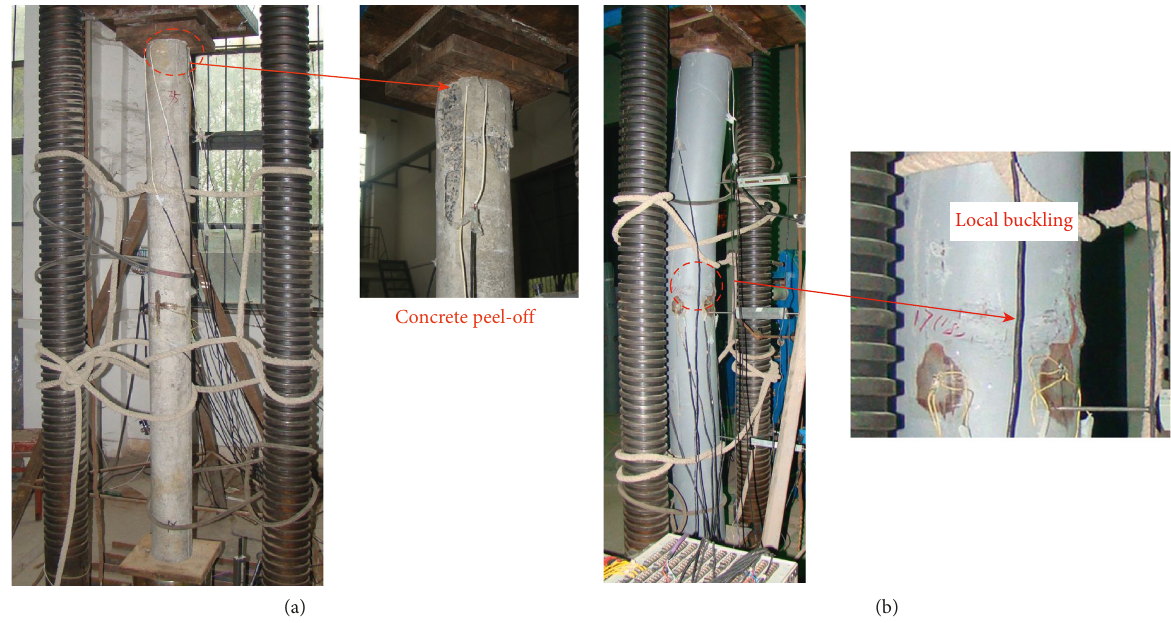
Figure 2: Typical failure modes of specimens. (a) Specimen Ref. (b) Specimen t3-C50-9.8.